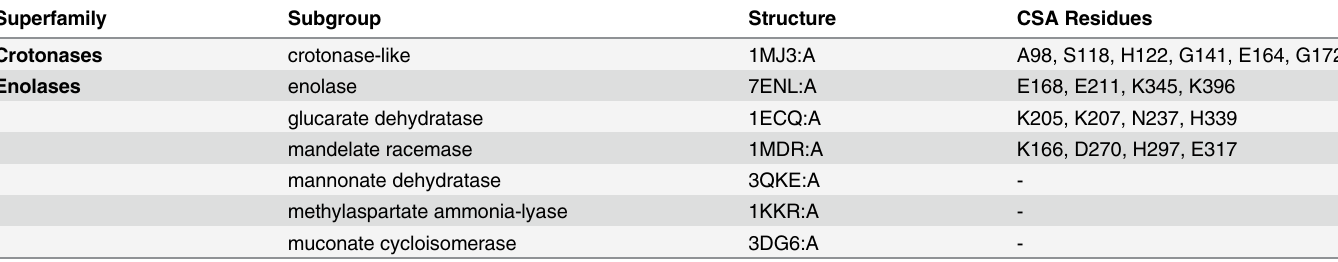
Table 3. Structures used as templates for modeling the SFLD superfamily sequences.